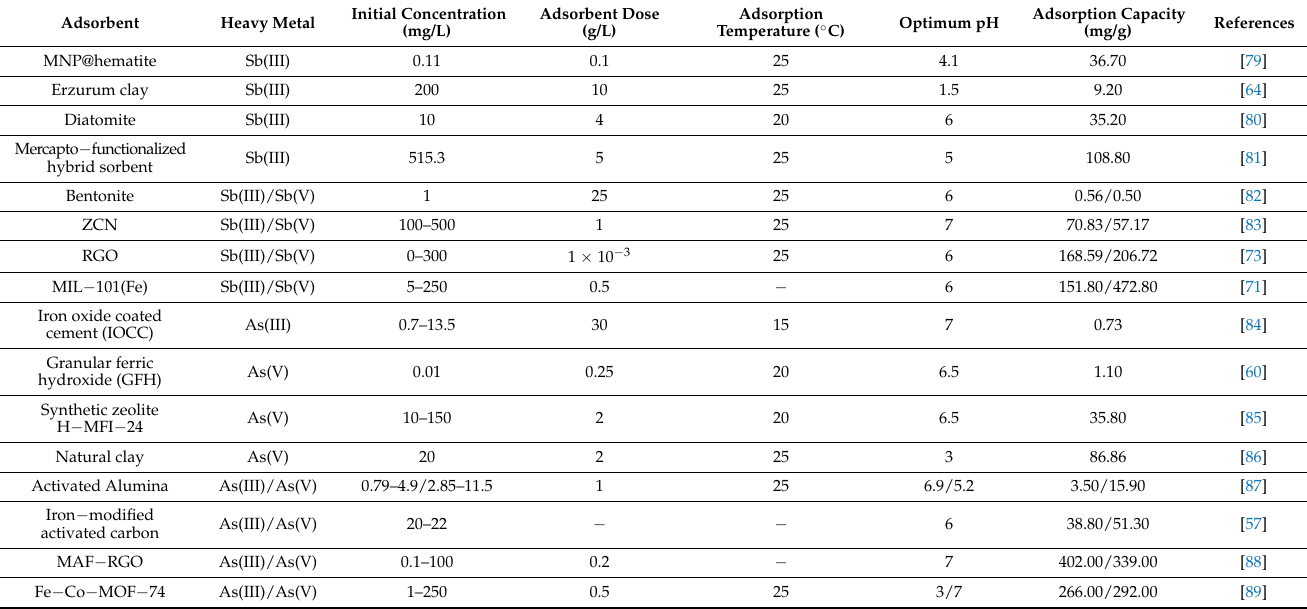
Table 2. Adsorption capacity and other parameters of different adsorbents for removing antimony and